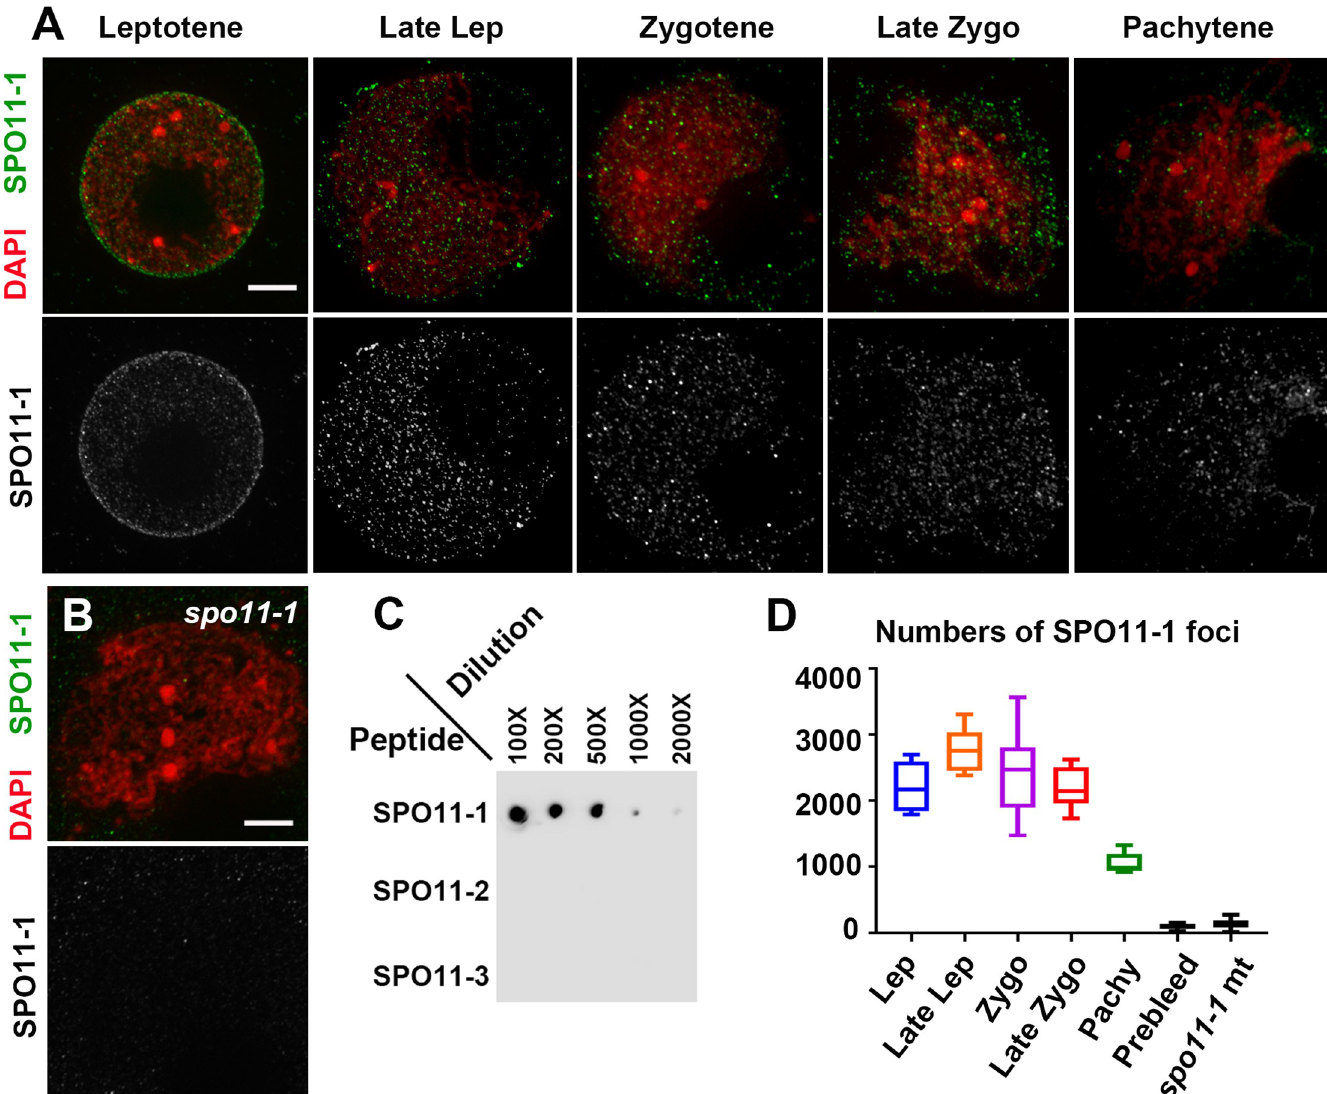
Fig 4. Numerous SPO11-1 signals are distributed in nuclei during early prophase I. (A-B ) Immunostaining of SPO11-1 (green) and DAPI-stained chromosomes (red) in WT meiocytes at different stages (A) and in a spo11-1 mutant meiocyte (B). SPO11-1 signals are shown as gray-scale in the lower panels. Scale bars represent 5 μ m. (C) Dot blot analysis of SPO11-1 antibody against SPO11-1, SPO11-2 and SPO11-3 peptides (see S7 Fig for details). (D) Numbers of SPO11-1 foci detected using the affinity-purified antibody in WT nuclei at different stages and in spo11-1- Δ 03 nuclei at early zygotene. Numbers of foci detected in WT nuclei using pre-immune serum (S7 Fig) are also shown